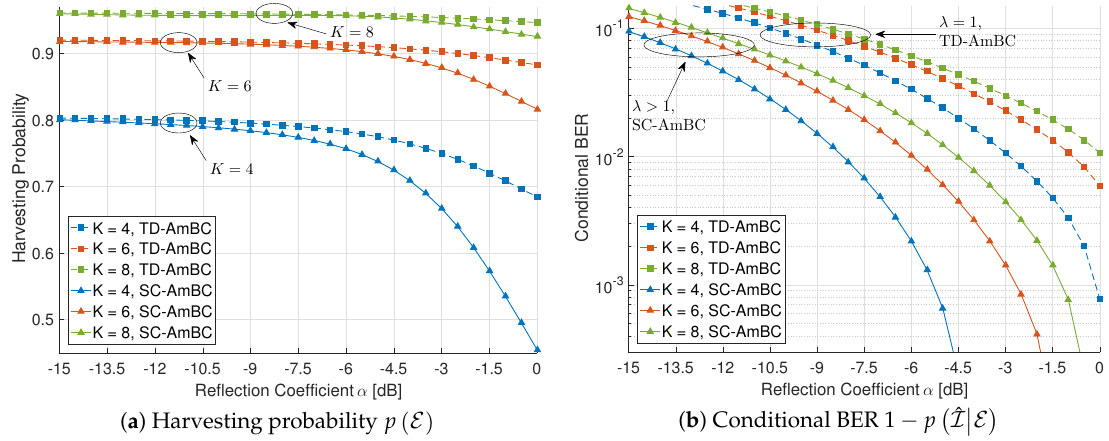
Figure 10. Effect of the number of time slots K ( M = 2, L + = 3).